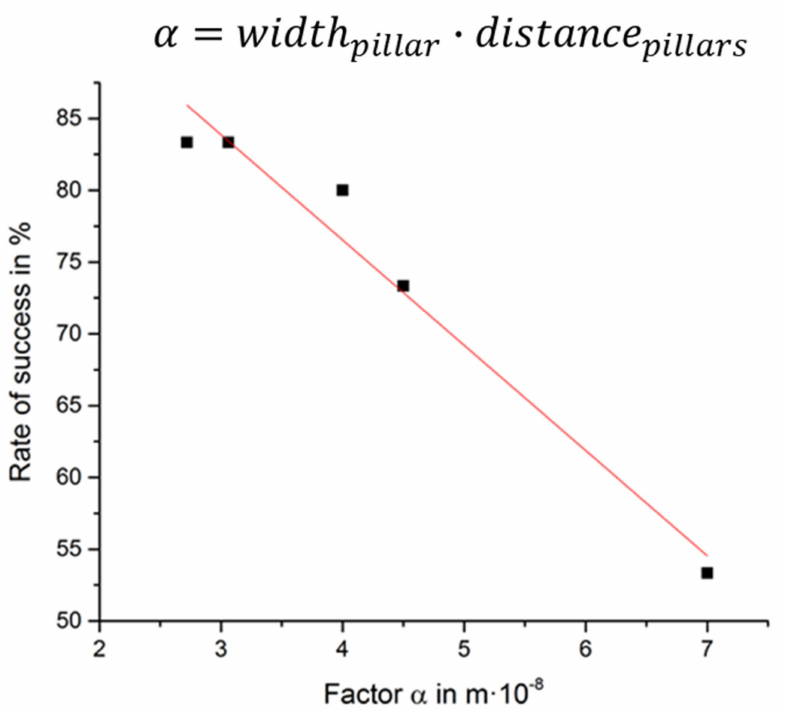
Figure A4. Success of priming of MFC with the hydrogel solution depends on pillar size and spacing as reflected by a factor α , with α being defined as the product of the pillar width and distance between two adjacent pillars. MFCs were filled at a flow rate of 2.5–3 µ L/min with hydrogel solution. Successful priming is achieved when no spillover occurs and perfusion of the adjacent “luminal” channel remains possible.